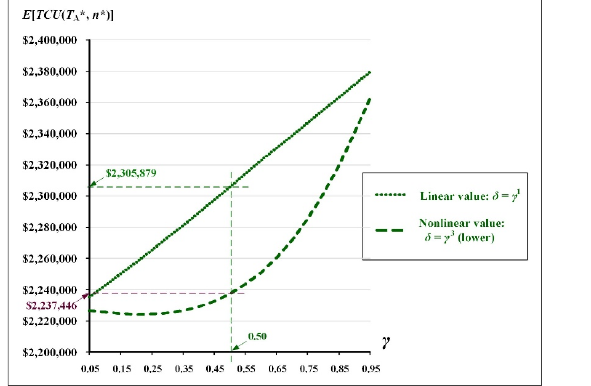
Fig. 12. The impact on T A * from different relationships between δ and γ